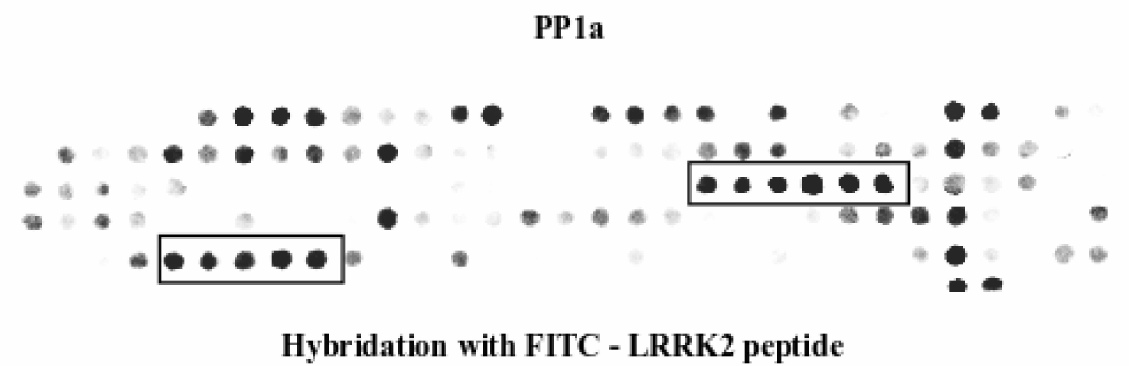
Figure 3. Identification of a binding site of PP1a to FITC-labeled LRRK2 peptide. The sequence of PP1a was developed as series of overlapping dodecapeptides with a shift of two amino acids. The membrane was hybridized with the FITC-labeled LRRK2 peptide that interacts with PP1a. Spots were detected by fluorescence. The peptides interacting with PP1a are boxed and the sequence